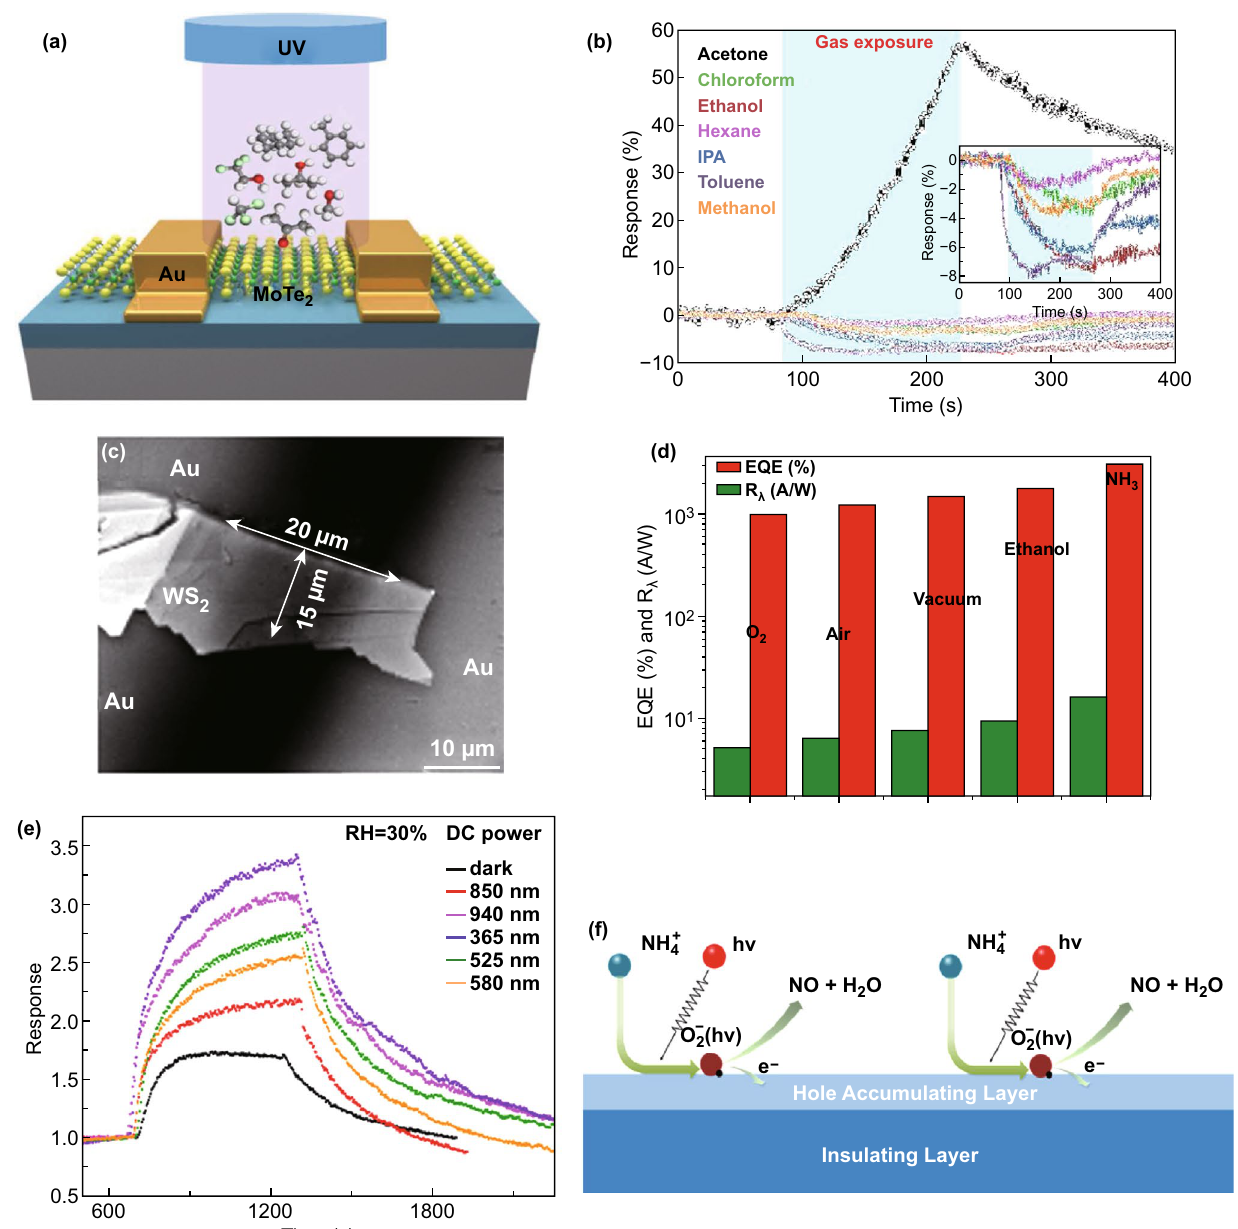
Fig. 16 a Schematic representation of a MoTe 2 sensor under UV light illumination. b Gas response to different VOCs under UV illumination. Reproduced with permission [40]. Copyright 2018, American Chemical Society. c SEM image of mechanically exfoliated WS 2 flake. d Pho- toresponsivity and external quantum efficiency of the WS 2 sensor under light illumination in different gas ambient. Reproduced with permission [135]. Published by Nature Publishing Group. e Gas response of the sensor to NO 2 gas under different wavelengths of light sources. f Gas sens- ing mechanism of the sensor under light illumination. Reproduced with permission [136]. Copyright 2017,